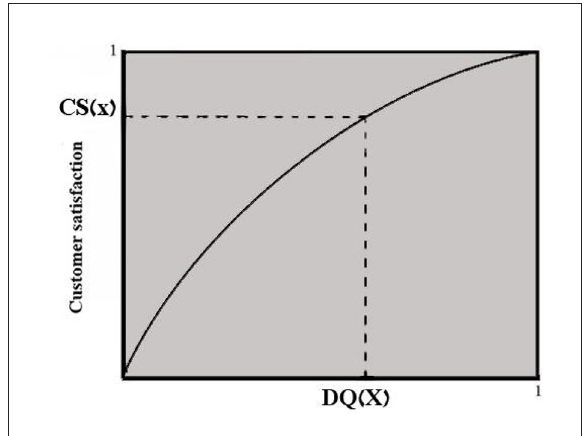
FIGURE2 Customer satisfaction (CS) and design quality functional curve (DQ).